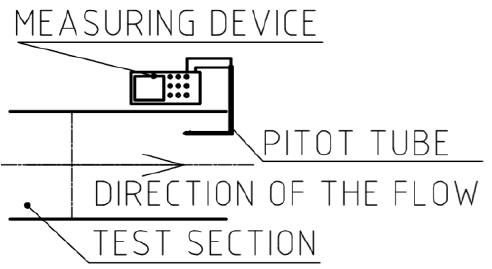
Fig. 6. Pitot static tube experimental setup